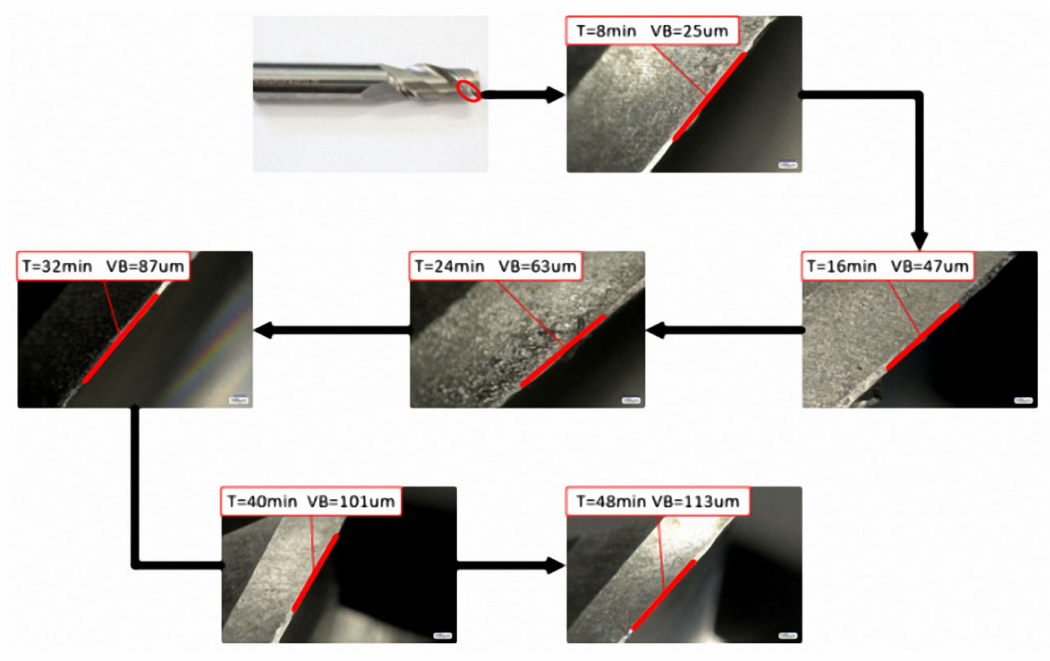
Figure 10. Experimental measurement